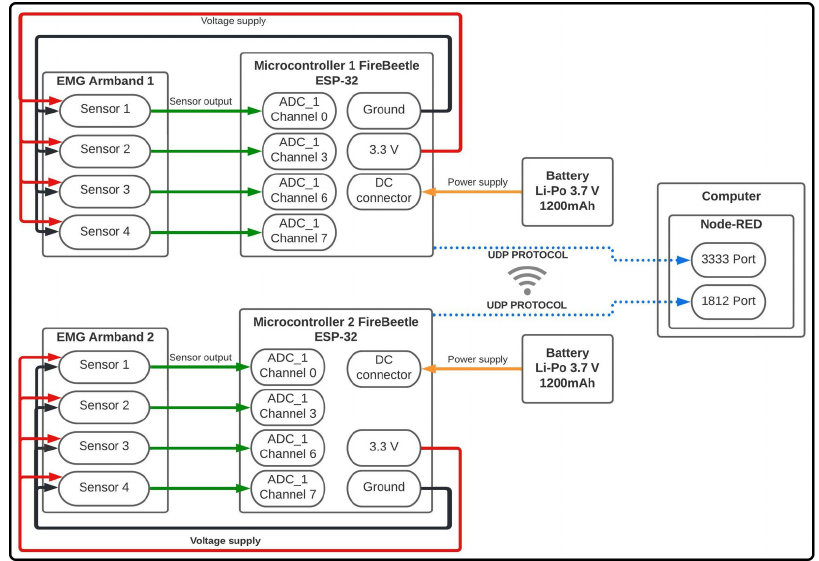
Figure 4. General electronic instrumentation of the WES.